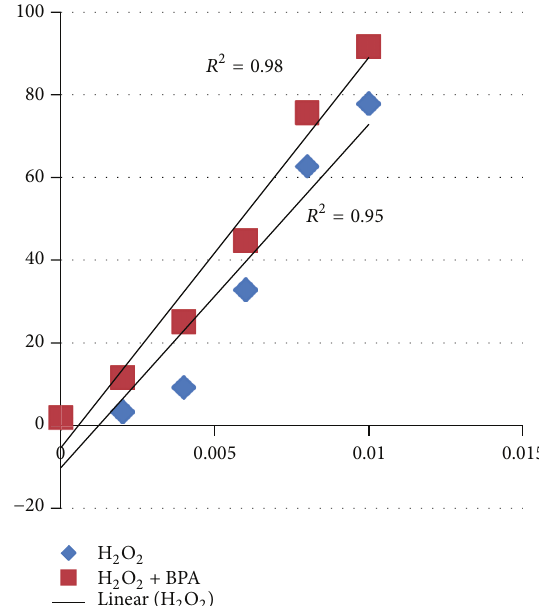
Figure 8: Correlation between H 2 O 2 and different concentration of H 2 O 2 along with the bisphenol A (50 𝜇